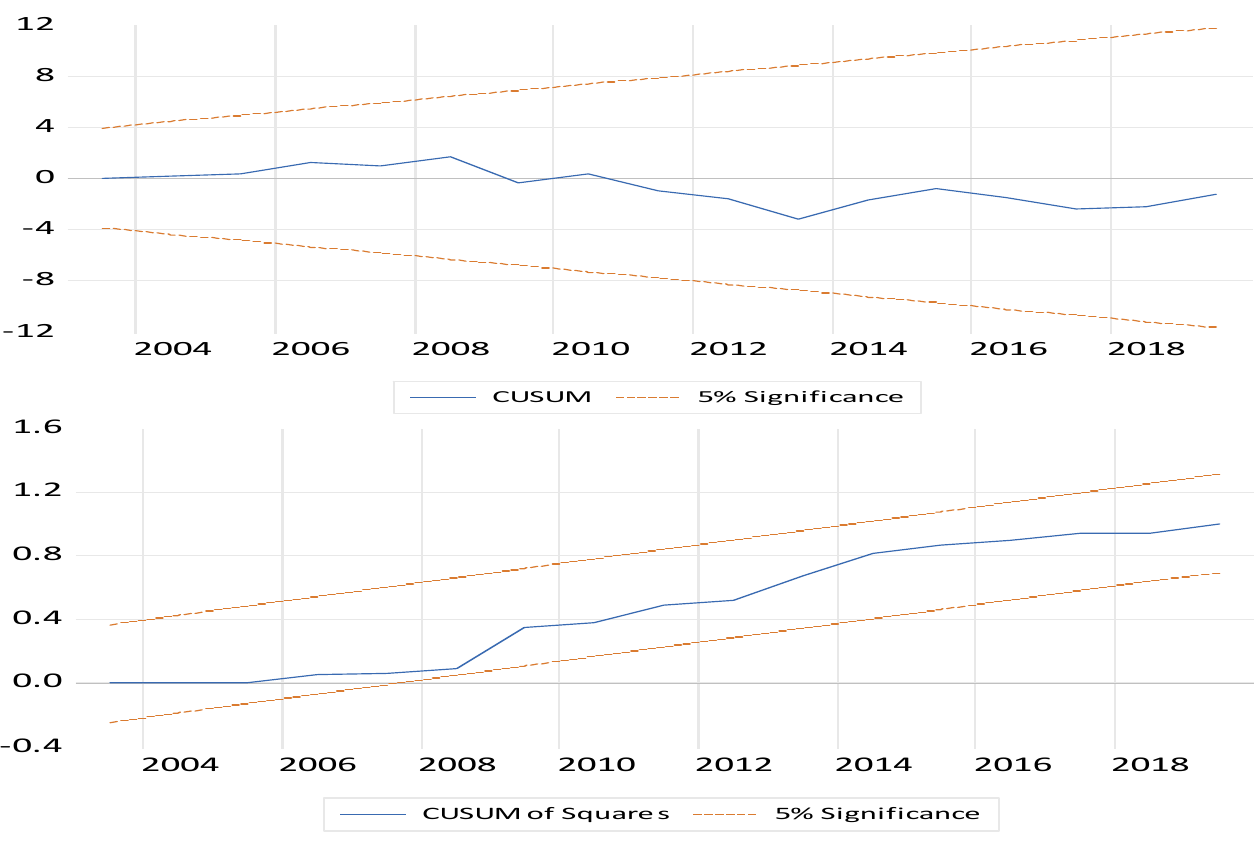
Figure 2. CUSUM stability test.